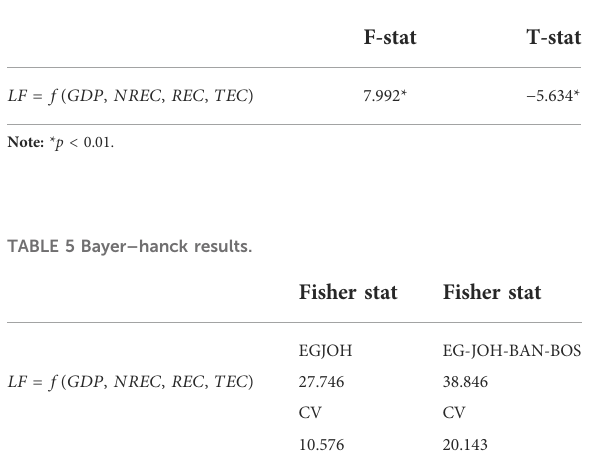
TABLE 2 Unit root outcomes.